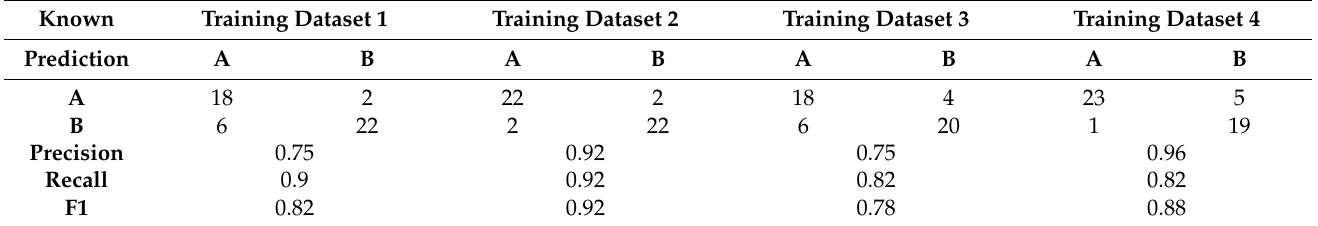
Table 6. Performance metrics for the GA–SVM models.